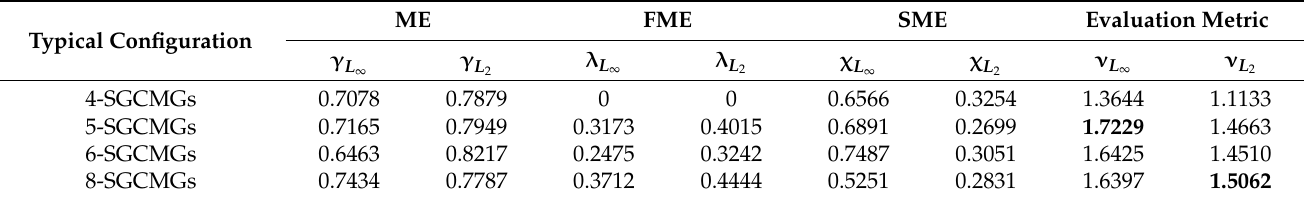
Table 3. Typical configuration performance